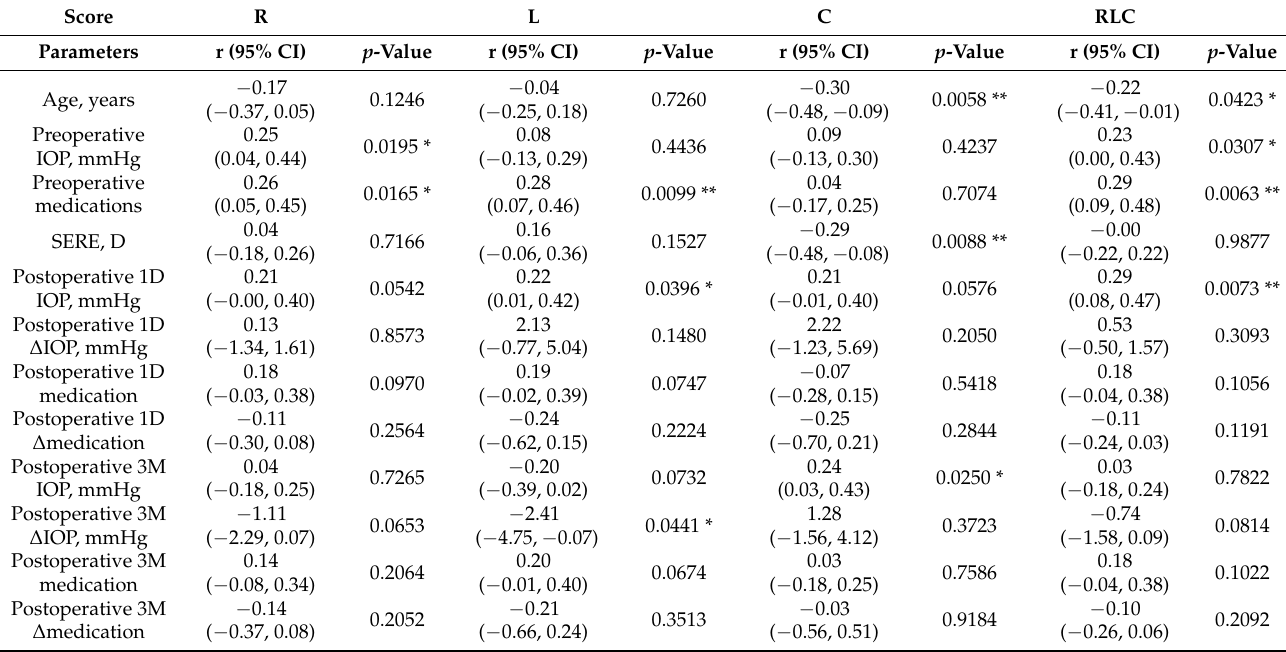
Table 4. Possible associations between RLC scores on postoperative day 1 and various continuous